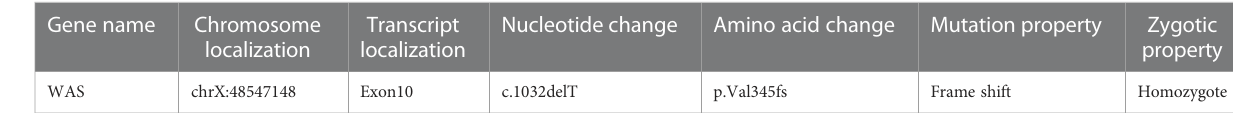
TABLE 1 Genetic variant strongly associated with